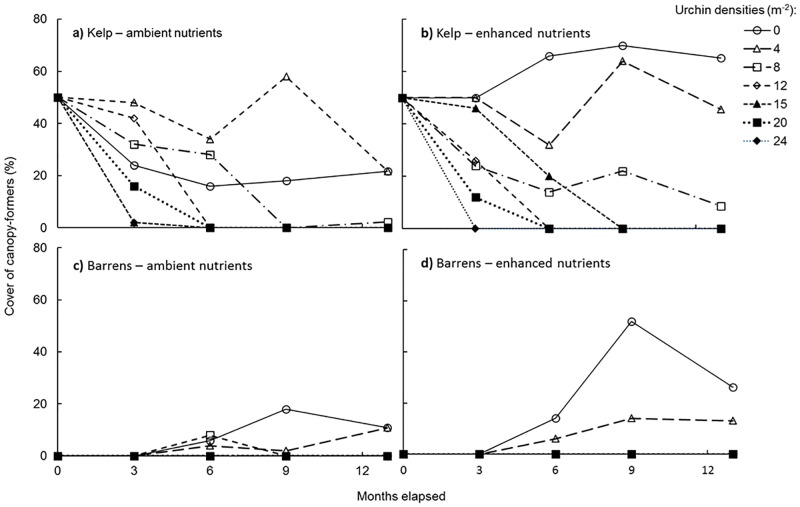
Kelp collapse and recovery at different urchin densities over time.Percentage cover of canopy-forming algae at a range of sea urchin densities (individuals m-²) on patch reefs initiated as the ‘kelp bed’ (a) and (b), and ‘barrens’ state (c) and (d) in northern Port Phillip Bay, Nov. 2012 to Dec. 2013. Plots (a) and (c) represent reefs with ambient nutrient levels, and (b) and (d) show results for reefs with enhanced nutrient levels.